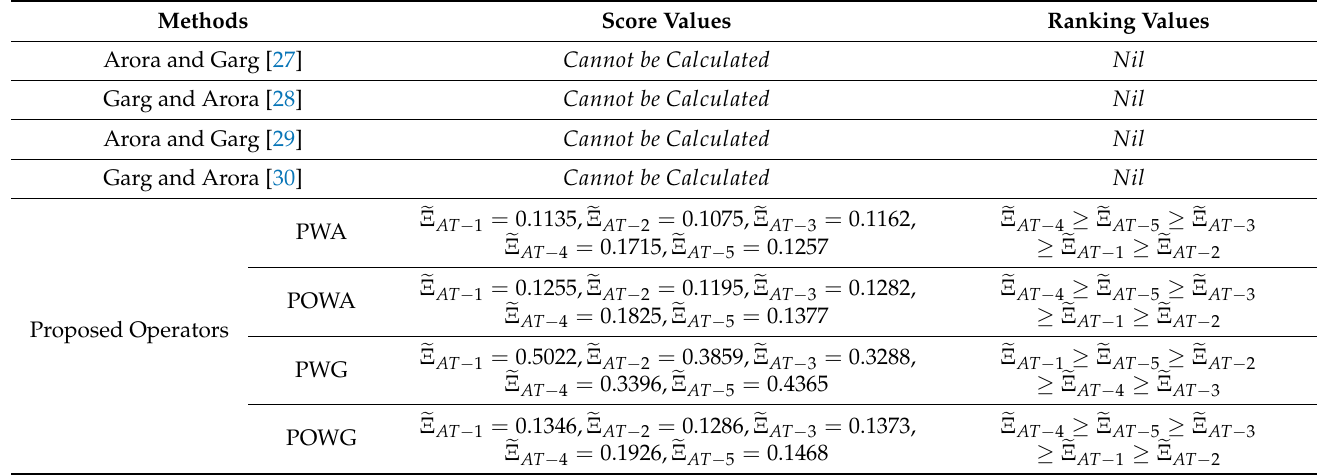
Table 12. Comparative analysis of the existing and elaborated